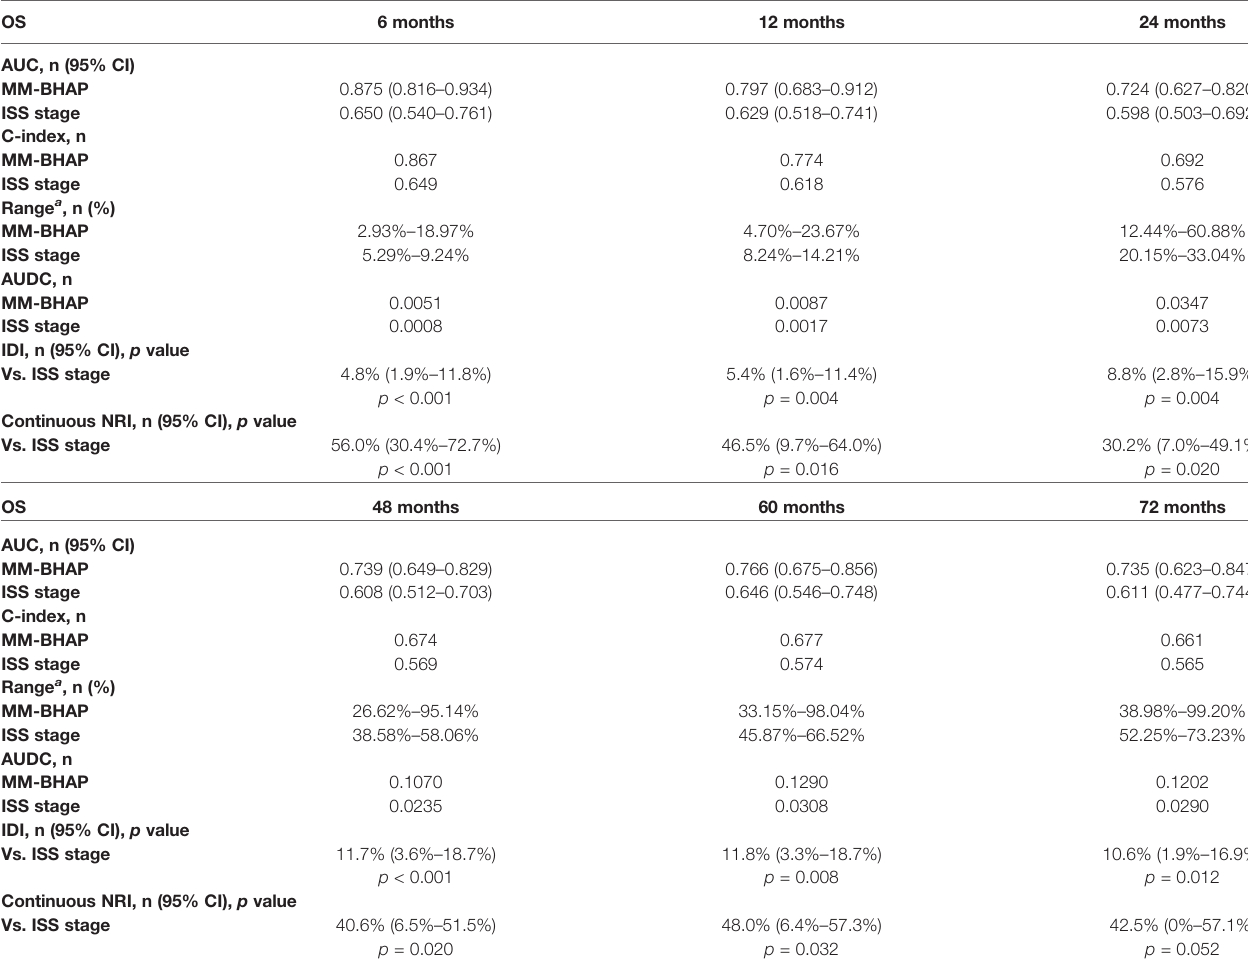
TABLE 5 | Comprehensive evaluations of the different models in the validation